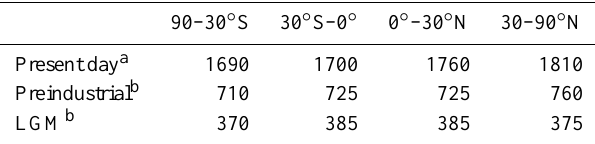
Table 3. Methane mixing ratios prescribed in GEOS-Chem